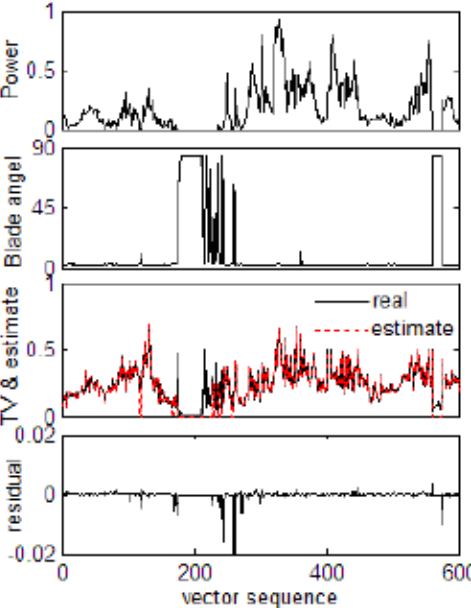
Figure 4. Validation for sub-model